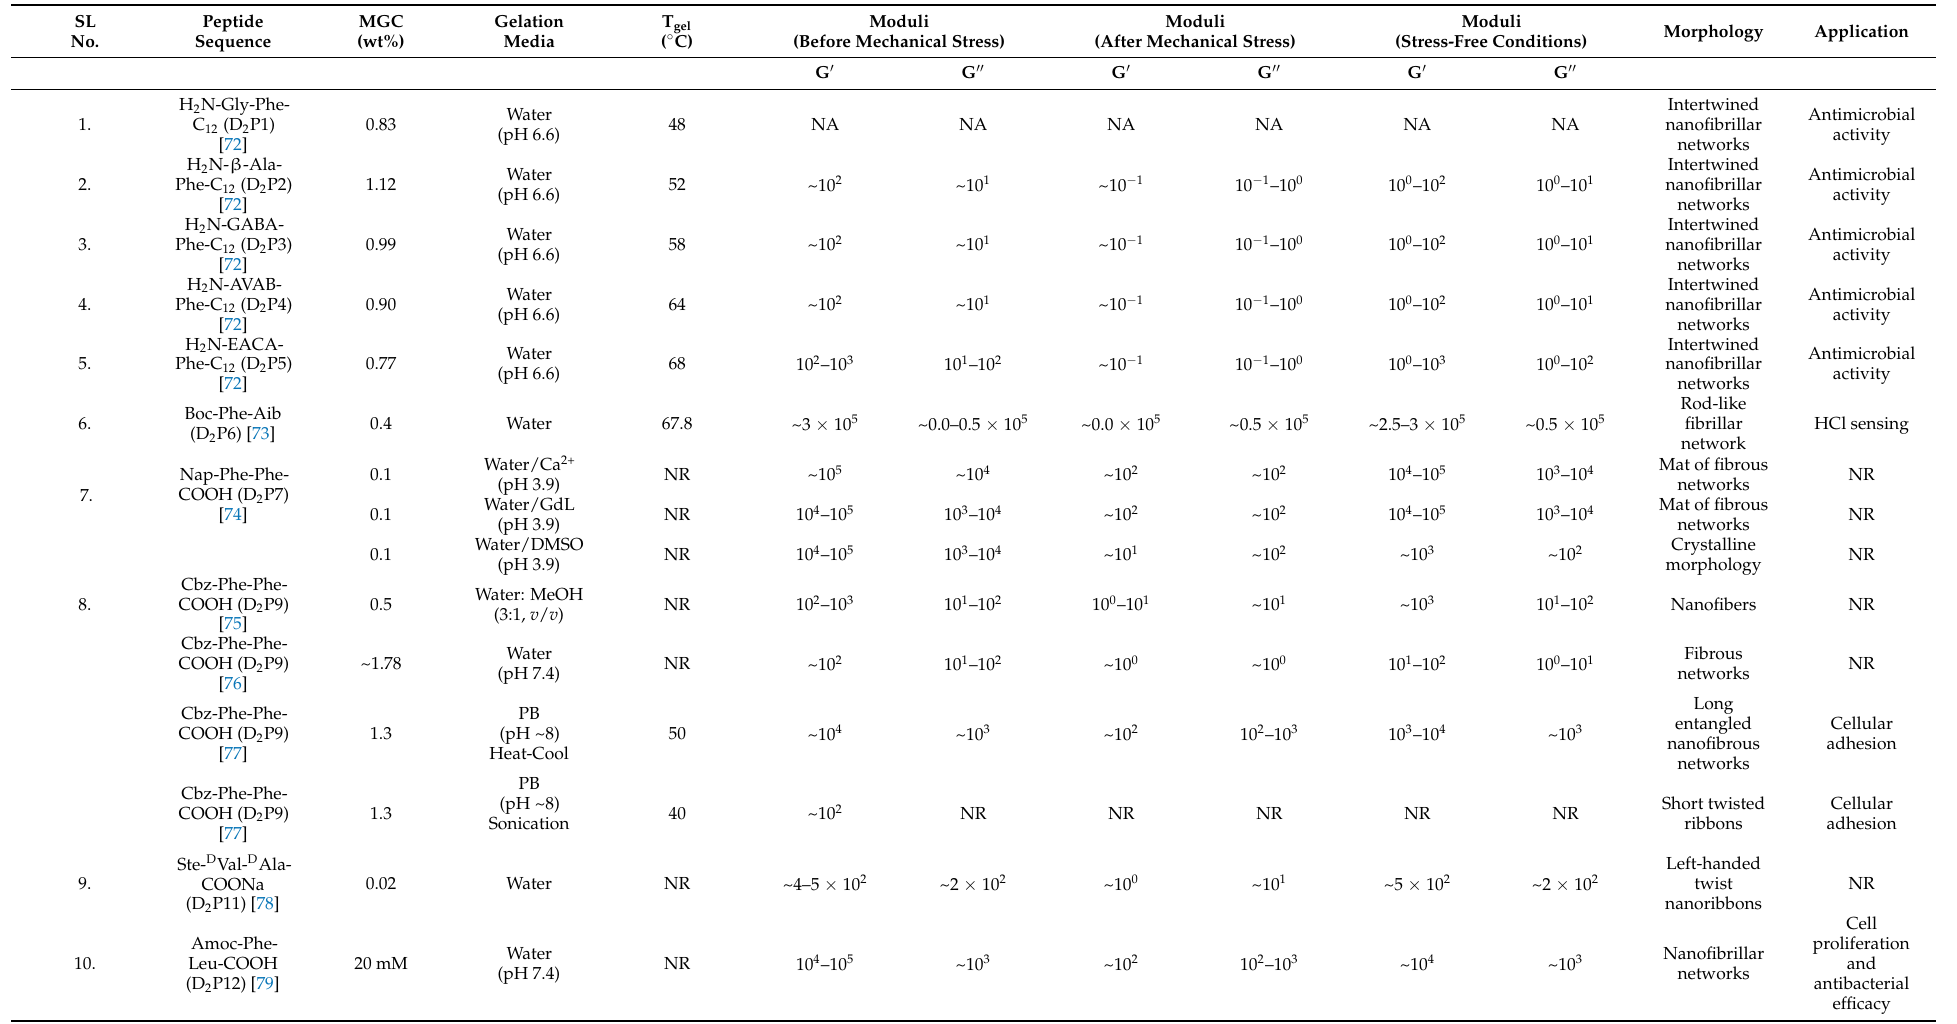
Table 2. List of dipeptide (D 2 P)-based thixotropic hydrogelators and respective gelation parameters. SL